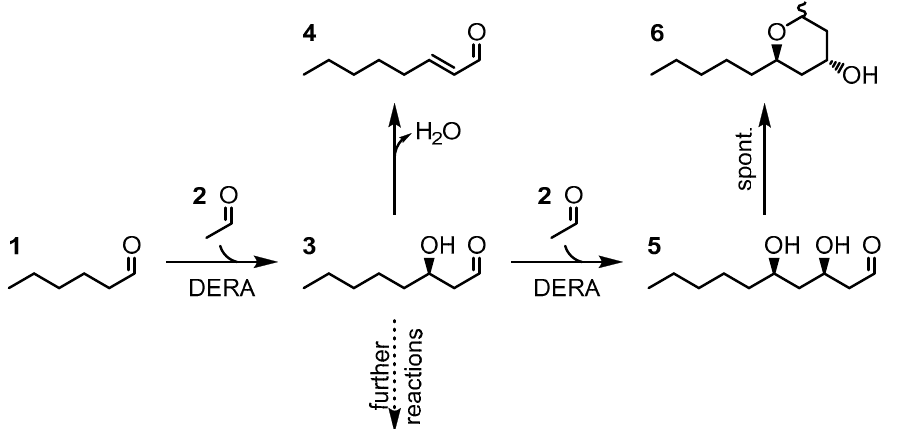
Figure 1. Reactions catalyzed via DERA, starting from hexanal ( 1 ). The DERA catalyzes the aldol addition between hexanal ( 1 ) and acetaldehyde ( 2 ), forming ( R )-3-hydroxy octanal ( 3 ), which may be used in further reactions [9]. The aldol condensation results in oct-2-enal ( 4 ). (R) -3-hydroxy- octanal ( 3 ) can participate in a second aldol reaction, forming ( R , R )-3,6-dihydroxy decanal ( 5 ), which spontaneously forms the hemiacetal 2,4-dideoxy-( R )-3-hydroxy-( R )-5-pentyl-pyranoside ( 6